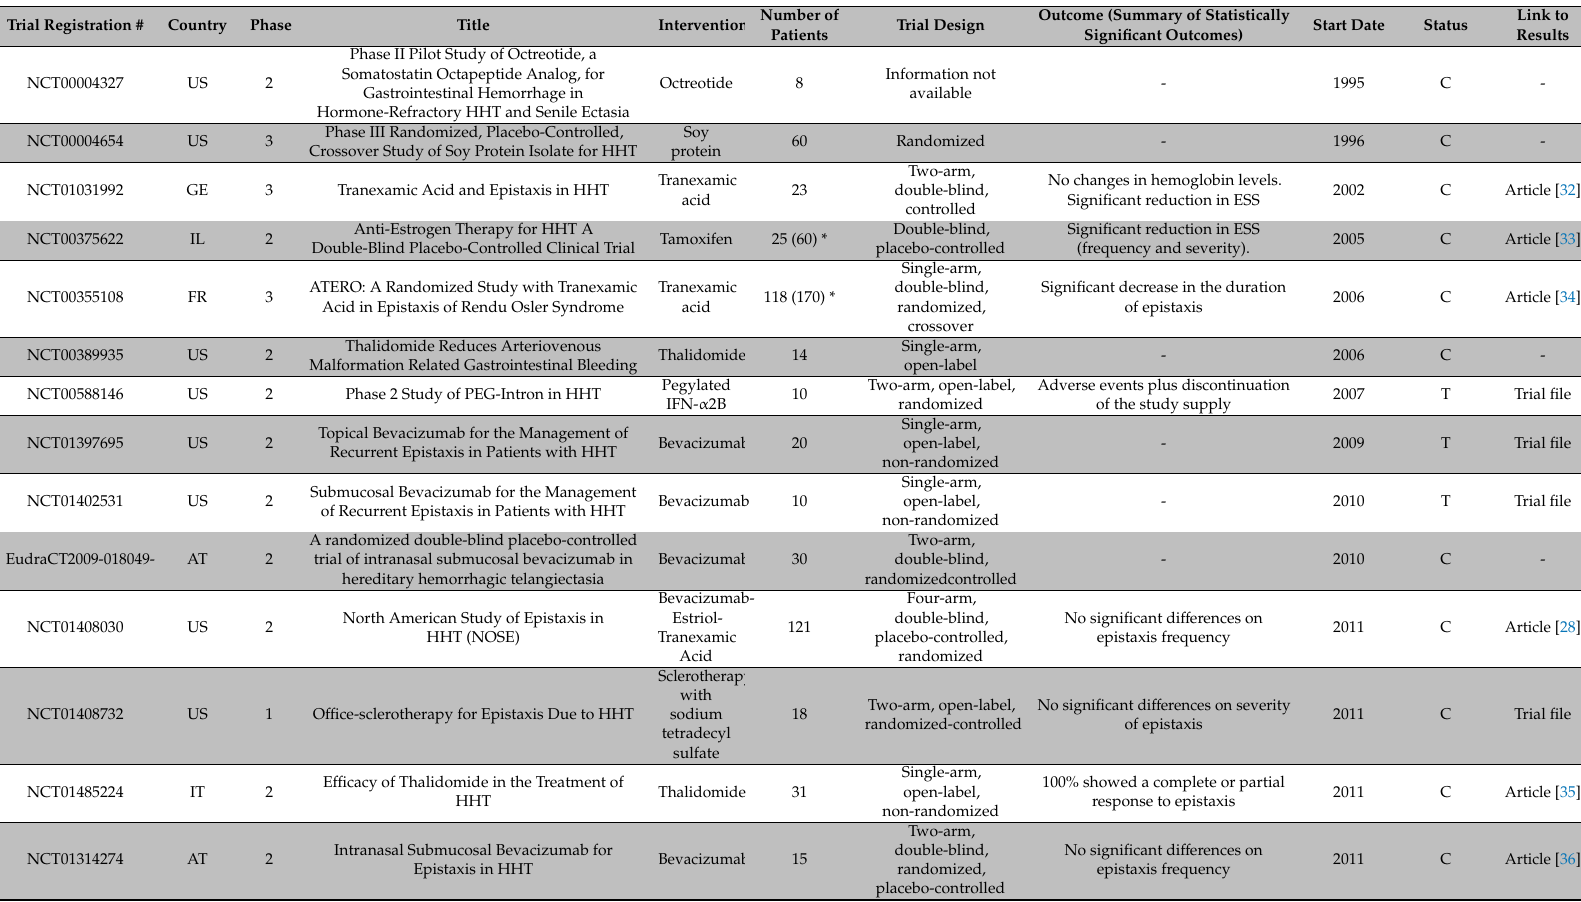
Table 3. Compilation of the HHT interventional clinical trials (Completed or Terminated